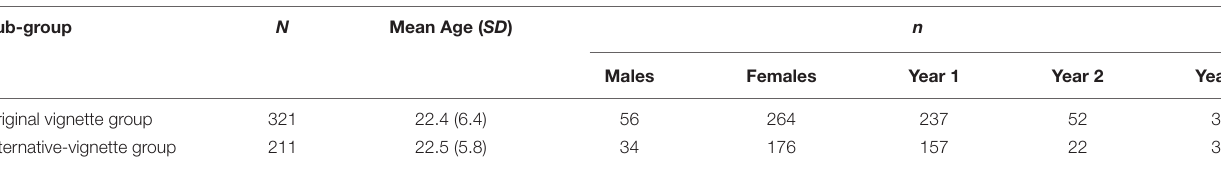
TABLE 1 | Sample details by